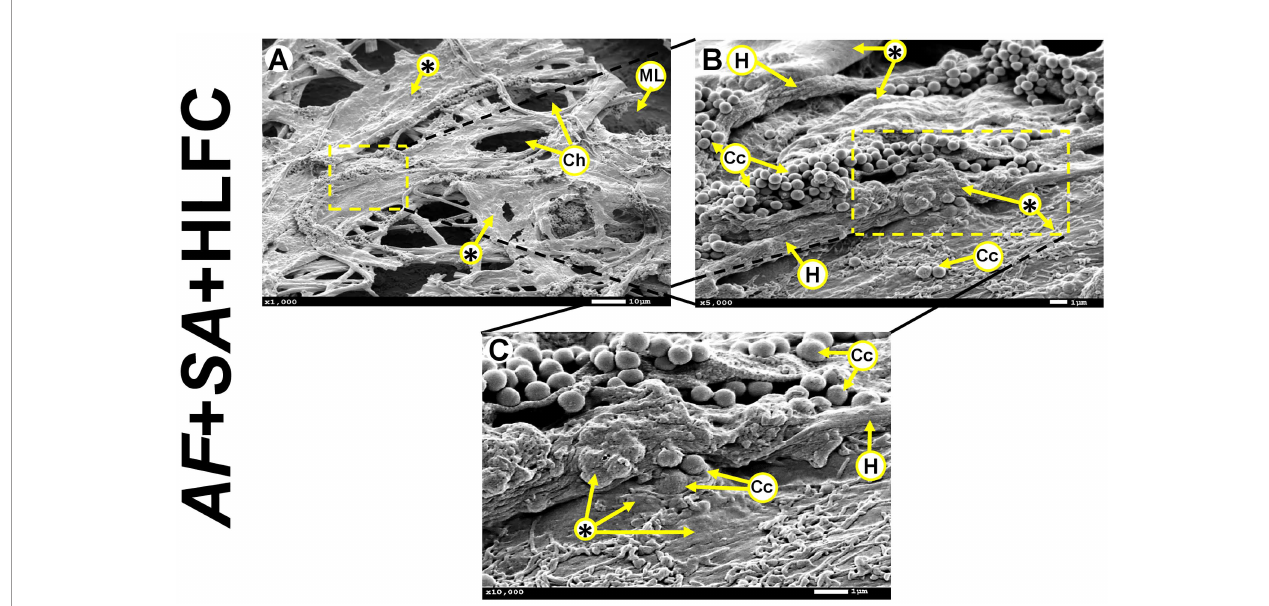
FIGURE 2 | MFBB on primary HLFCs. SEM micrographs of 24-h bio fi lm of AF+SA at different zooming ( A : 1,000×; B : 5,000×; C : 10,000×). ECM air channels and fi broblast monolayer are observed (A) . Cocci and hyphae are seen embedded in a condensed extracellular matrix (B, C) . MFBB, mixed fungal – bacterial bio fi lm; HLFCs, human limbo-corneal fi broblast cells; AF, Aspergillus fumigatus ; SA, Staphylococcus aureus ; H, hypha; Ch, channels; Asterisk (*), extracellular matrix (ECM); ML, monolayer; Fp, fi lopodia; Cc,